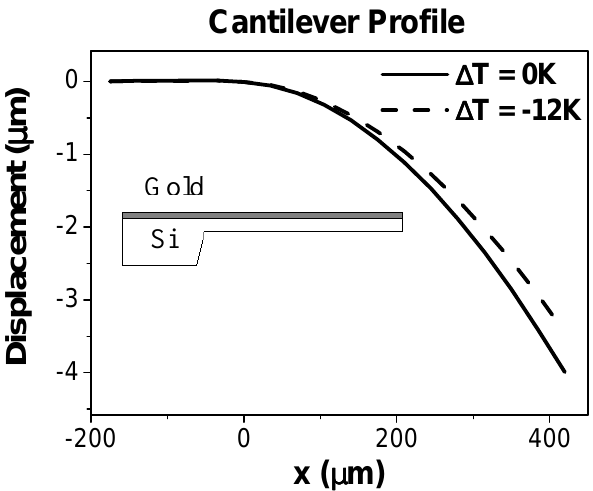
Figure 3 . The cantilever profiles for ∆ T= 0K and ∆ T=-12K are presented. The cantilever bends upwards when the temperature decreases. A schematic depiction of the cantilever is also shown to relate the sign of the cantilever bending to the orientation of the bimetallic cantilever. The profiles were obtained in medium vacuum (10 -2 Pa).